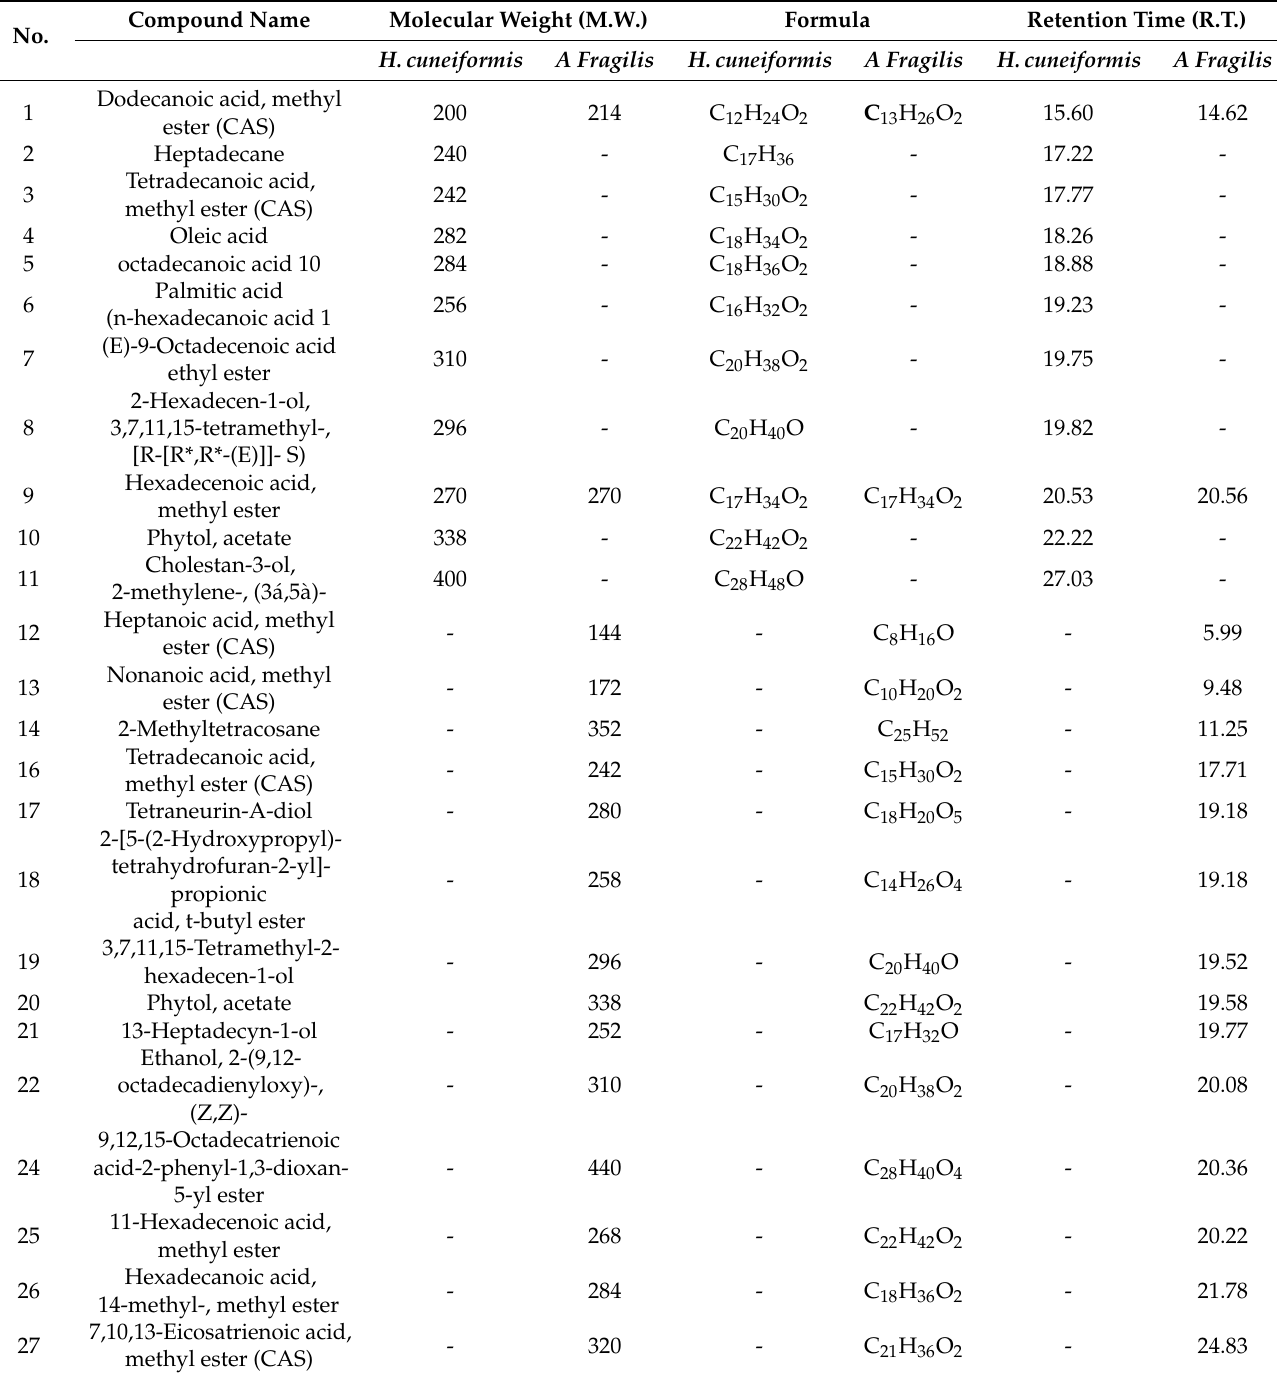
Table 1. GC-MS profiles of phytochemical compounds of H. cuneiformis and A. fragilis